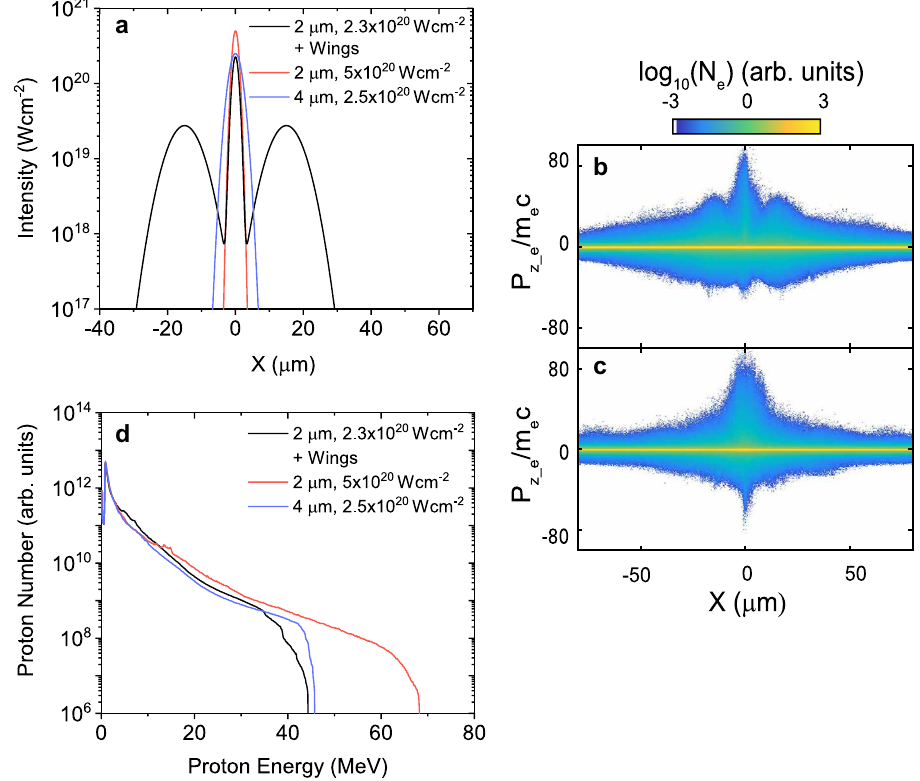
Figure 3. Simulation results illustrating the effects of the focal spot wings. ( a ) Example input focal spot spatial- intensity profiles for the 2D PIC simulations, for given focal spot diameter, intensity and profile conditions. ( b ) Longitudinal momentum of all electrons obtained 100 fs after the peak of the laser interaction, shown as a function of the transverse position (the laser is incident at X = 0 ), for a 2 µ m diameter focal spot including wings. ( c ) Same for a 4 µ m diameter spot without wings. ( d ) Example proton energy spectra obtained for given focal spot diameter, intensity and profile